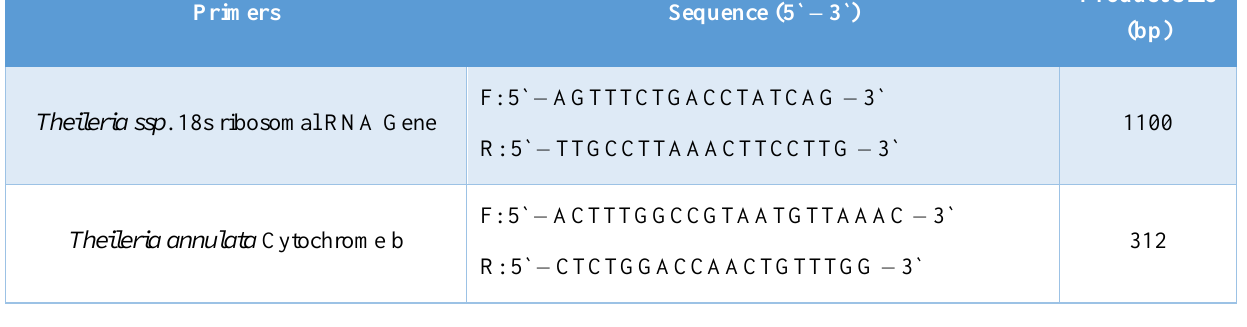
Table, 1: Primers and their sequence that used in study. Primers